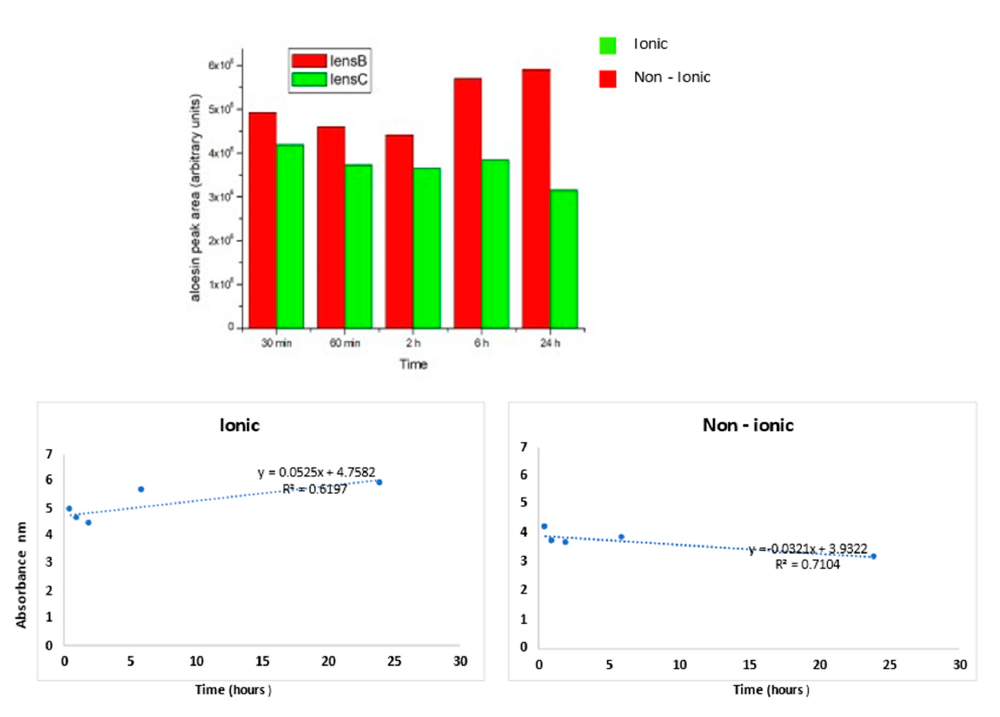
Figure 4. Aloesin amount released from ionic and non-ionic lens after 2 and 24 h. The blue peak overwhelms the red peak at all tested times, thus indicating the more abundant release of aloesin from the ionic lens compared to the non-ionic lens.